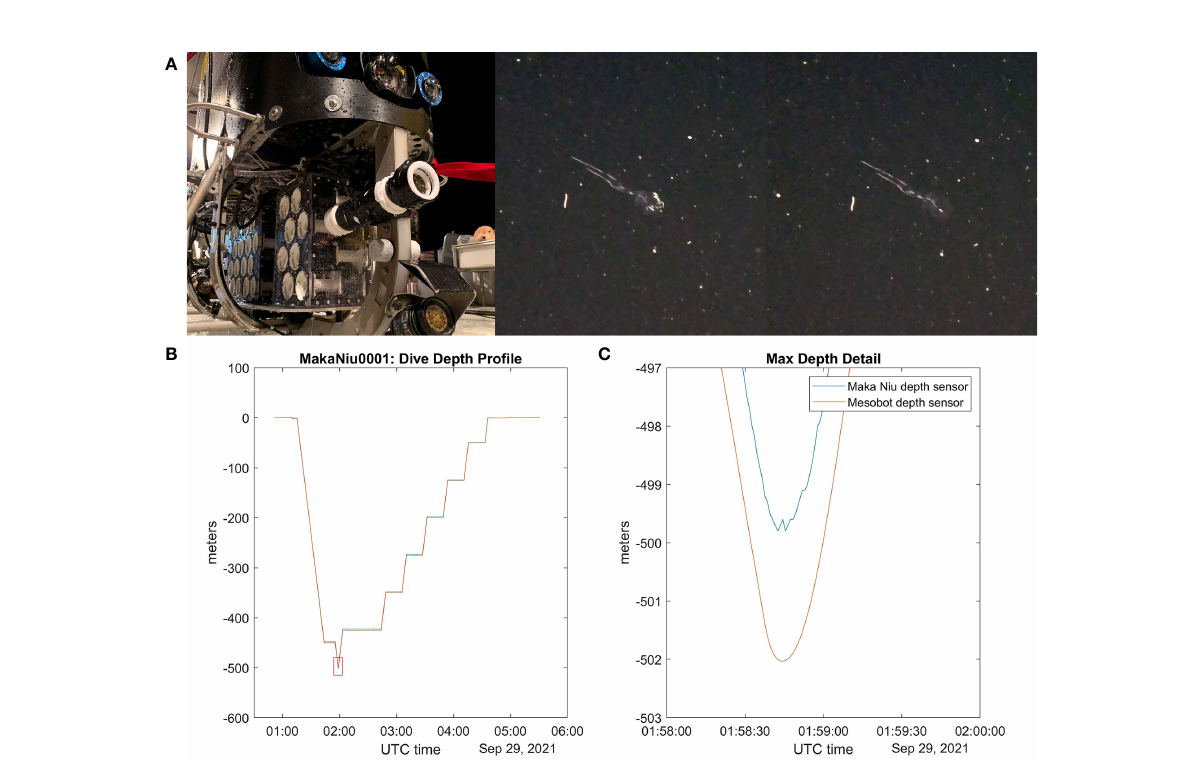
FIGURE 9 (A) Maka Niu was mounted to Mesobot below and in parallel to its main camera system. (B) Stills from a video recorded by Maka Niu of a fl ashing marine animal. (C) The depth pro fi le for one of the dives, using independent data from Maka Niu and from Mesobot, shows the relative agreement between their